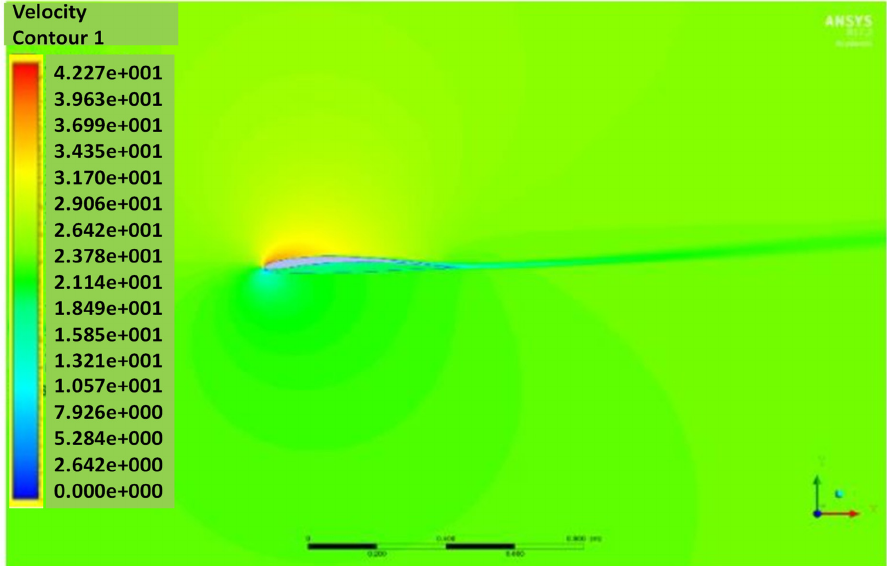
Figure 21. Pressure contour of the NACA2410 to 8410 transition at AoA 5°.